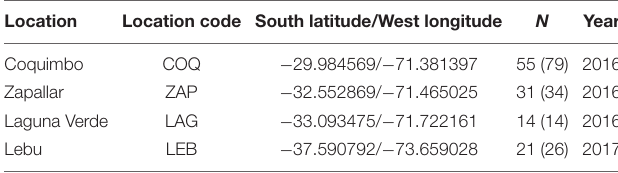
TABLE 1 | Sampling location, coordinates and sample sizes ( N ) analyzed in this study. Location Location code South latitude/West longitude N Year